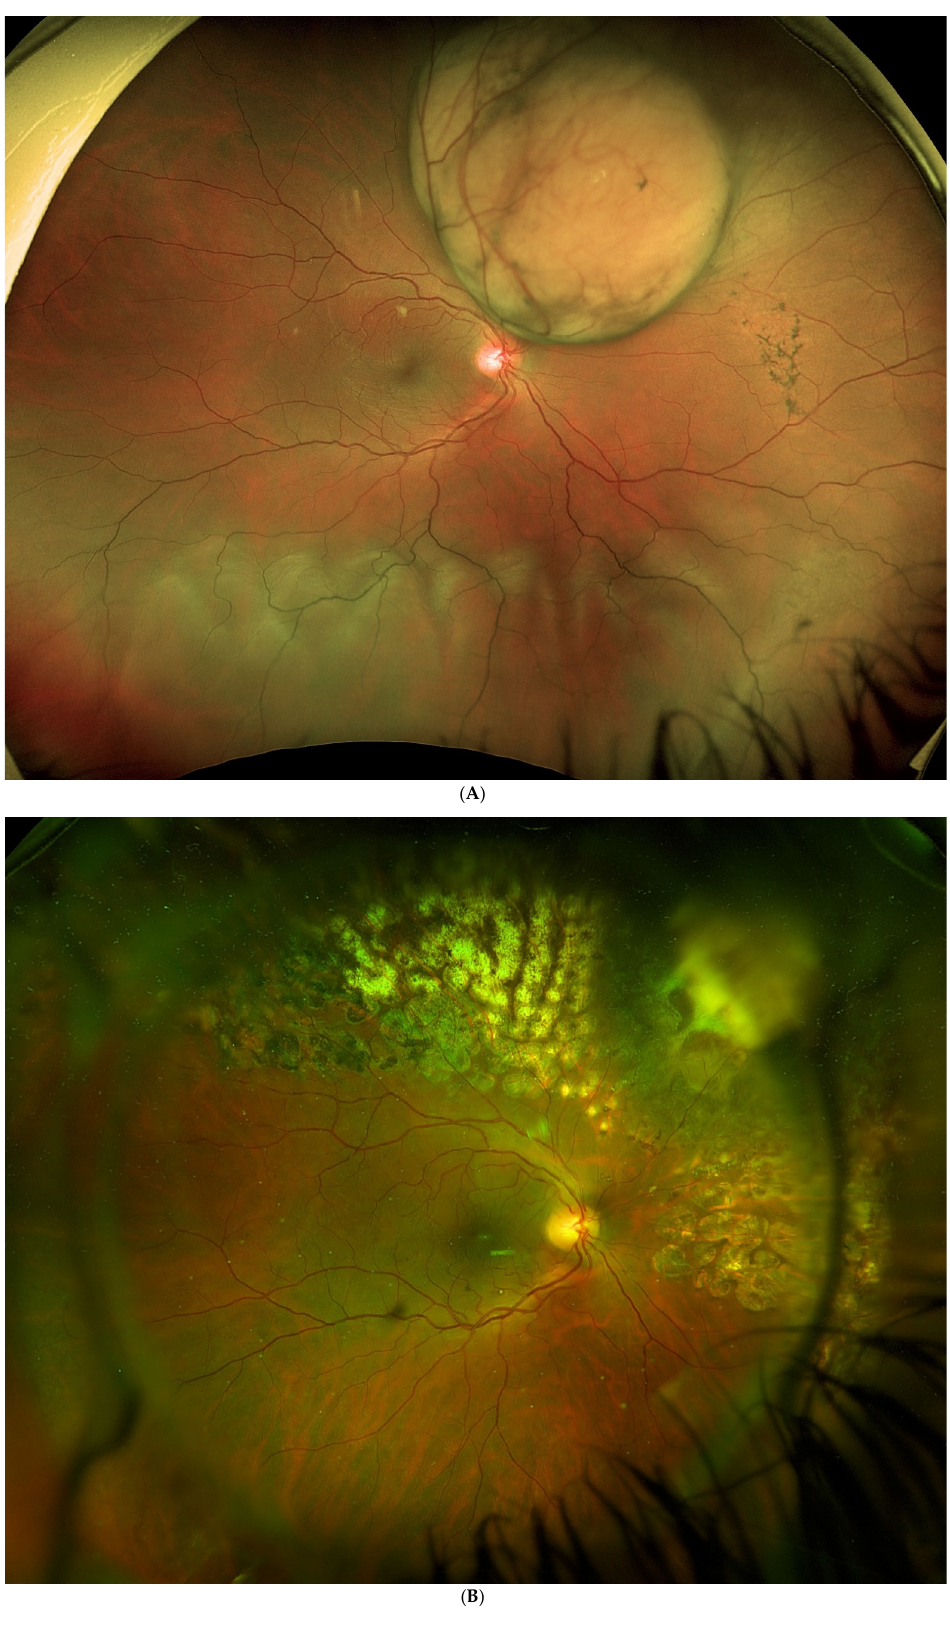
Figure 4. ( A ). Tumour located superior and postequatorial, with extensive inferior retinal detachment, in which an endoresection was performed. ( B ). Fundus image shows the surgical coloboma, as well as the perilesional photocoagulation and retinal reattachment. When this technique was first performed, an air–silicone exchange was used to flat- ten the retina after the tumour had been removed; however, this maneuver can cause a potentially lethal syndrome known as presumed air by vitrectomy embolisation (PAVE). Therefore, it is strongly advised to avoid this maneuver and instead perform a direct ex- change of perfluorocarbon liquid with silicone. [51–55] 4.2.3. Metastasis and Death Although endoresection has been widely questioned because it does not follow the classic concept of en bloc tumour removal with safety margins, it is currently widely used because studies have demonstrated good long-term results with this approach. Initially, there were some concerns regarding the risk of incomplete resection, implantation of can- cer cells in the vitreous, and dissemination of tumour cells into the bloodstream (due to piecemeal removal of the mass with the vitreous cutter), as any of these could theoretically increase systemic disease or local recurrence. However, the available data have shown that these risks are lower than originally believed. For example, Suesskind et al. [56] found